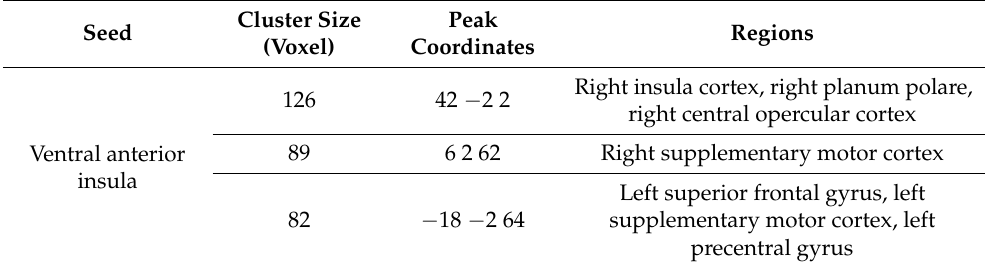
Table 2. Insula seed functional connectivity clusters associated with singing ability